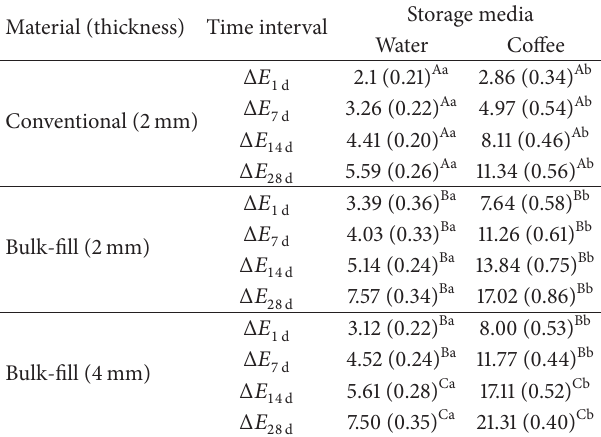
Table 2: Mean (SD) of Δ𝐸 values at different time intervals and storage